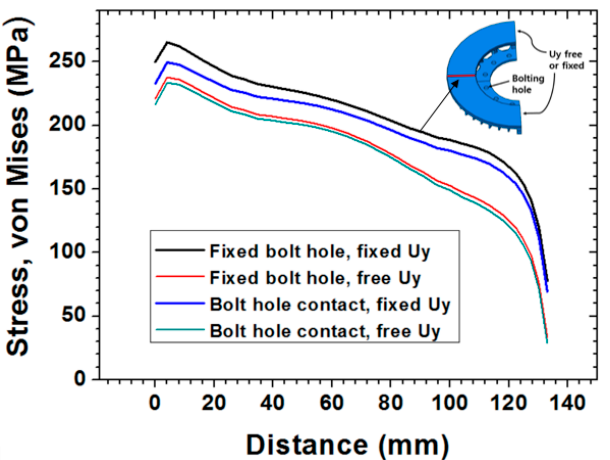
Figure 8. Stress along the symmetric line on the surface of the disc at t = 10.26 s under uniform heat flux. To determine the relation between the heat flux input profiles and temperature profiles using finite element analysis, the obtained temperature data were fitted to a curve with the same order as the heat flux input. All curve fits were carried out using Excel (MS Office 2012). Figure 9 shows that the correlation coefficients, R of the curve-fitting of the temperature data were near to one, which means that the temperature and heat flux profiles have similar types of profiles. When the heat flux input was linear in the radial direction, the temperature profile was also linear. In this case the coefficients of correlation (R) were R = 0.95–0.96. The temperature distribution was linear in the radial direction except near both edges. For quadratic heat flux, R = 0.99. The temperature profile in the radial direction retained a quadratic function. For the quartic heat flux input, the temperature profile maintained a quartic function. From the results it can be said that temperature profiles in the radial direction on the brake disc can be fitted by a function with the same order as the heat flux profile. Using temperature profiles of the disc surface obtained with an infrared camera, heat flux profiles can be inferred, and then pressure profiles can be estimated. [Note that heat flux = µ p(r)rw .] It seems that the results of this study provide a new approach to estimating the contact pressure between brake disc and pads and for other similar cases.